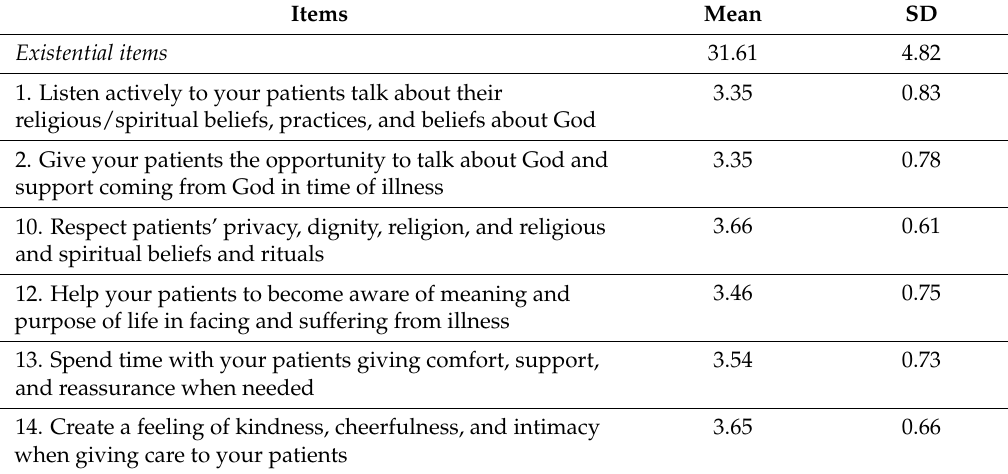
Table 4. The spiritual care interventions provision among nurses (n =